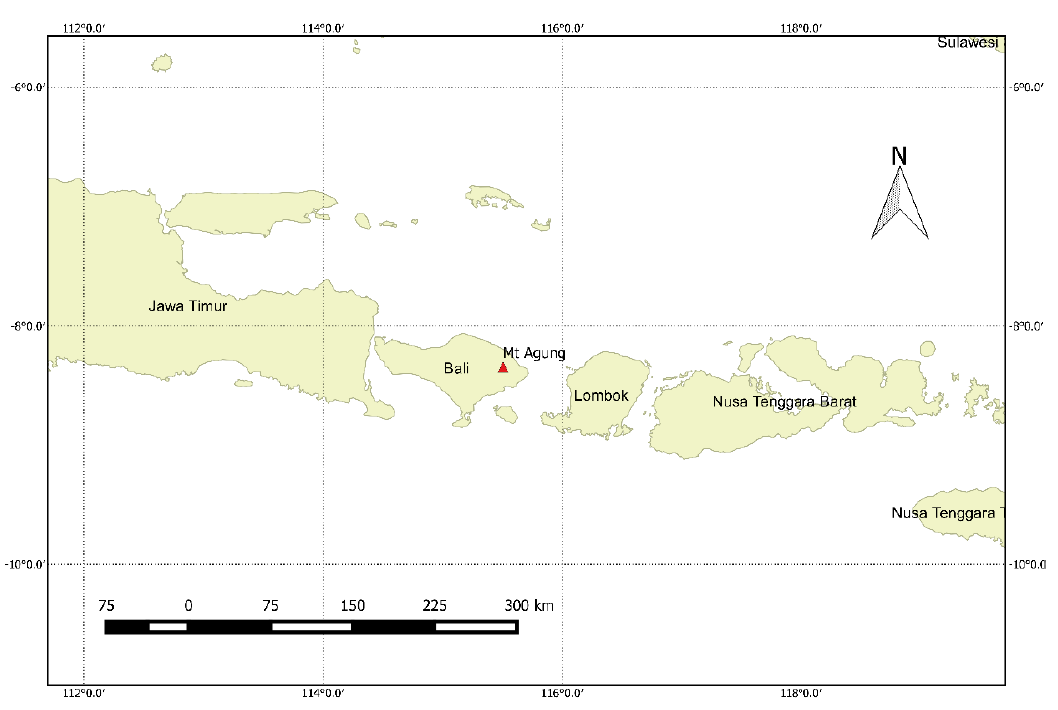
Figure 1. Geographic location of Mt. Agung (Bali; Indonesia).